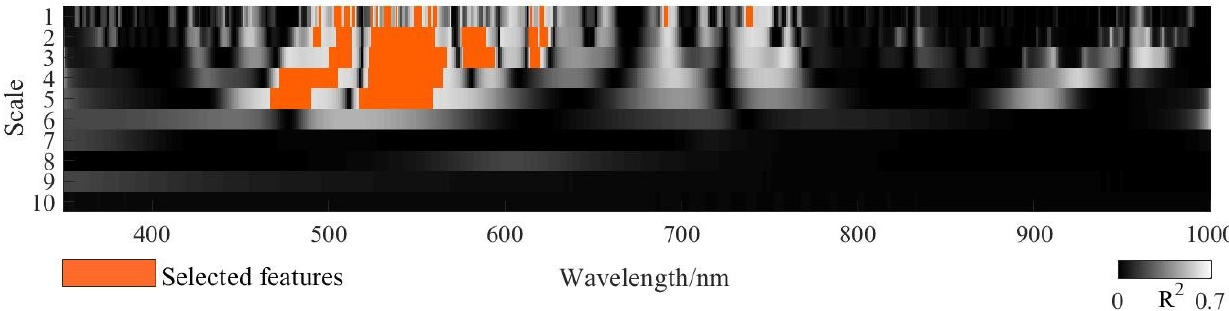
Figure 6. Visualization of the correlation scalogram generated using continuous wavelet analysis. The orange region represents a sensitive wavelet feature region (R 2 > 0.62). Table 2. Wavelength positions and scales of identified wavelet features.